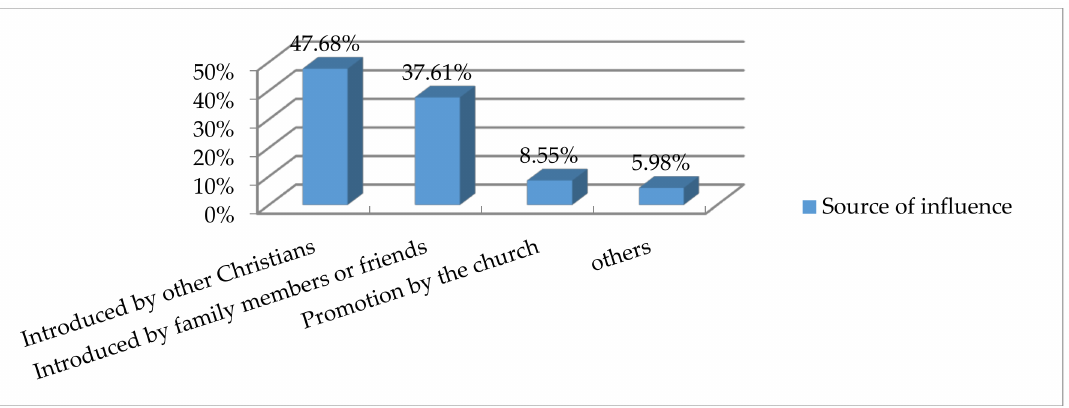
Figure 1. Source of influence on approaching sites of religious practice.